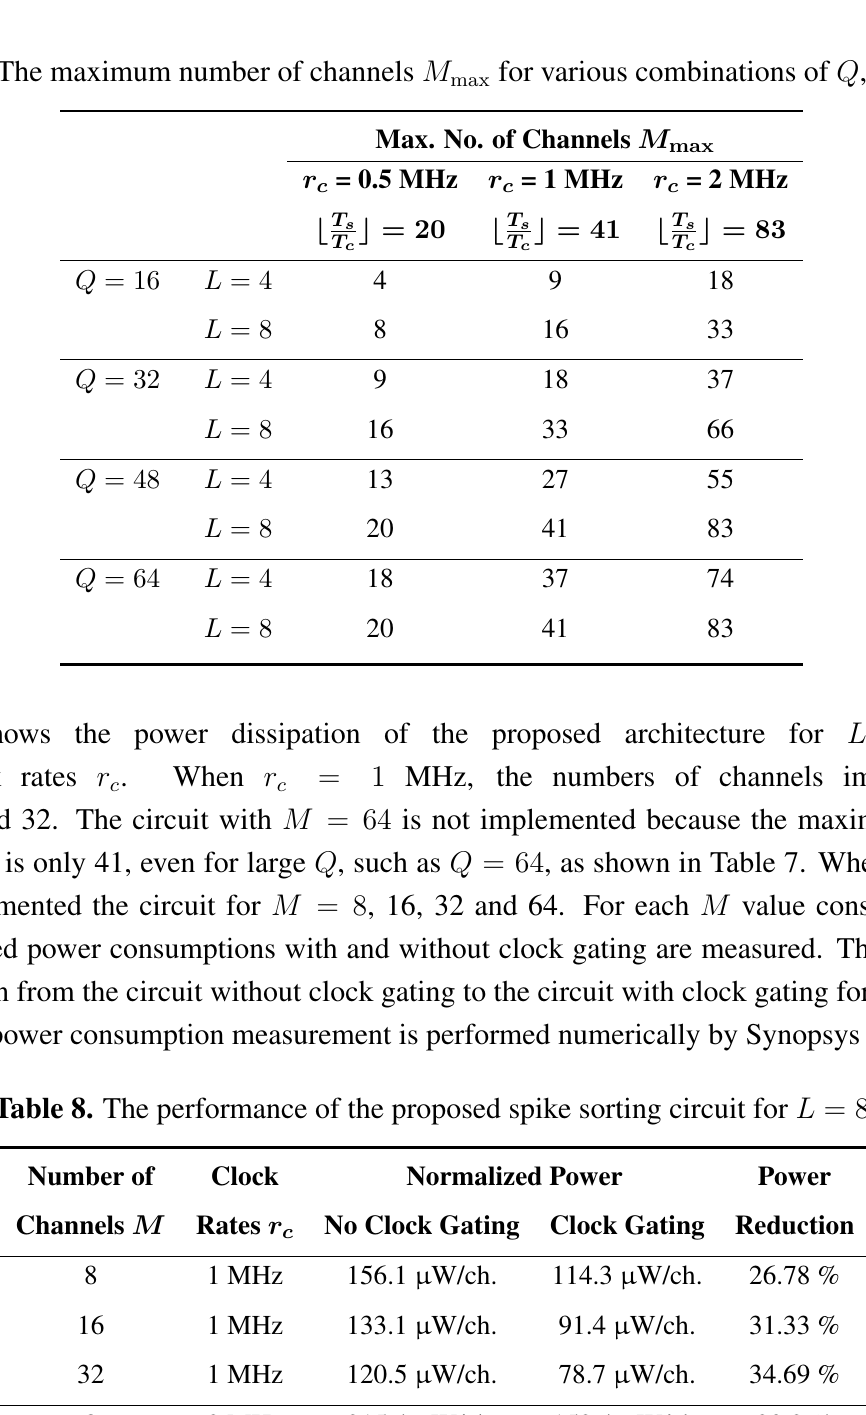
Table 7. The maximum number of channels M